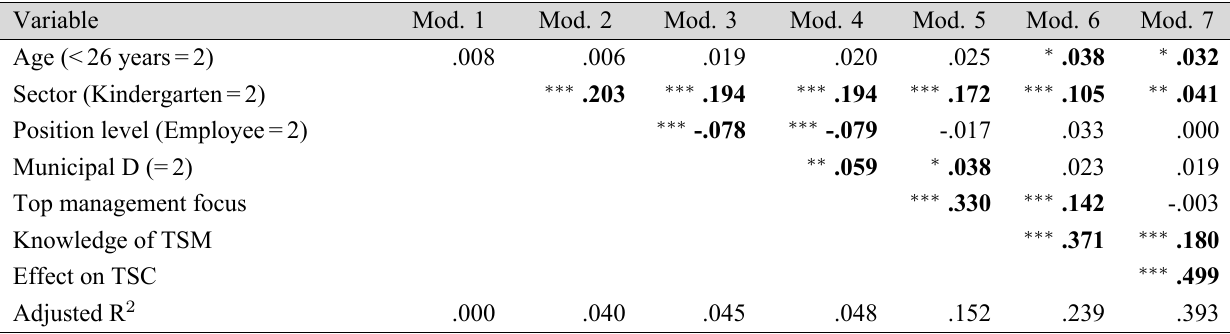
Table 6 Linear regression. Dependent variable: ‘The fact that we have been approved as a Traffic Safe Municipality has led to the following: “I think more about traffic safety in my everyday work.” ’ Standardized beta coefficients.